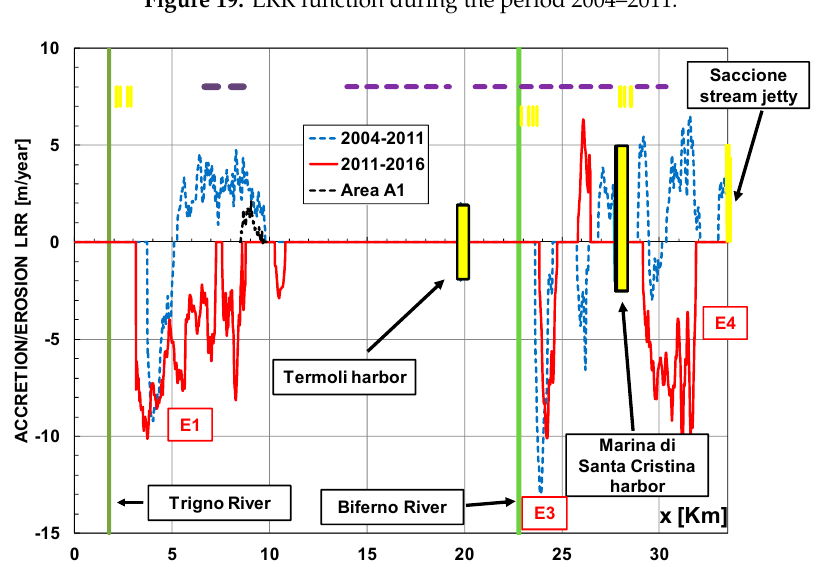
/ accretion areas for the periods 2004–2011 and Figure 20. Erosion/accretion areas for the periods 2004–2011 and 2011–2016. Figure 20. Erosion